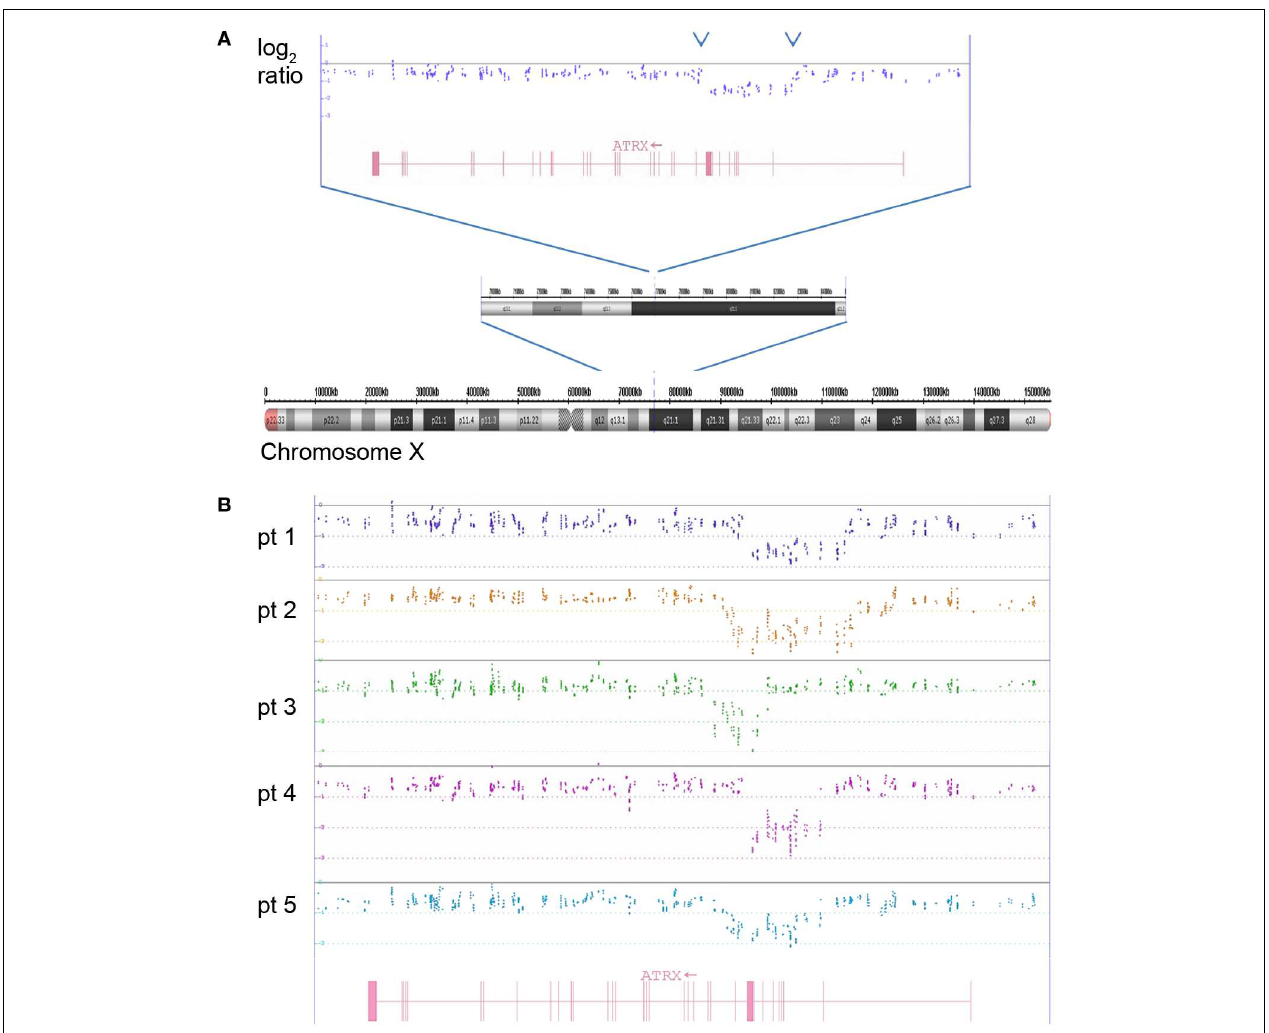
of ATRX is shown in red (vertical bars are exons). (B) Five examples of ATRX deletions spanning different parts of the gene are depicted (log 2 ratio from five neuroblastomas are shown in different colors analyzed with the ChAS